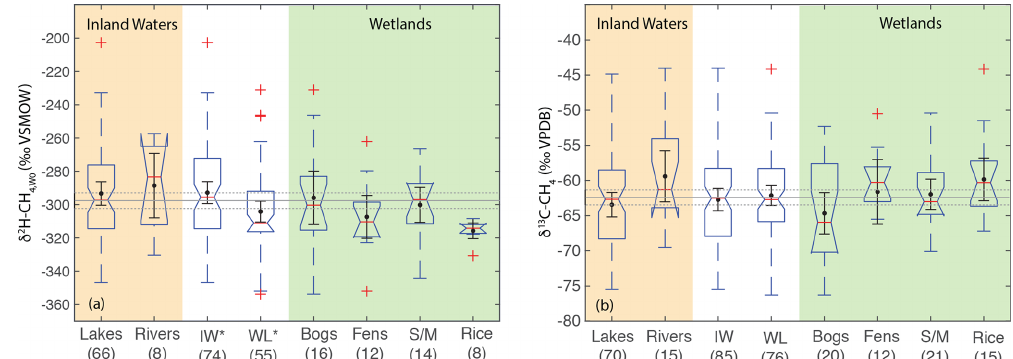
Figure 8. Boxplots of (a) δ 2 H–CH 4 ,W 0 and (b) δ 13 C-CH 4 for sites differentiated by ecosystem type. Numbers in parentheses indicate the number of sites for each category. Boxplot parameters are as in Fig. 7. Black points and error bars indicate the category mean and 95% confidence interval of the mean. Grey lines indicate the mean values across all categories, and the dashed lines indicate the 95% confidence interval of this value. Two extremely low outliers ( < − 80‰; lake and fen) are not shown in (b) . IW – inland waters; WL – wetlands; S/M – swamps and marshes. Asterisks in A indicate that inland waters and wetlands have significantly different